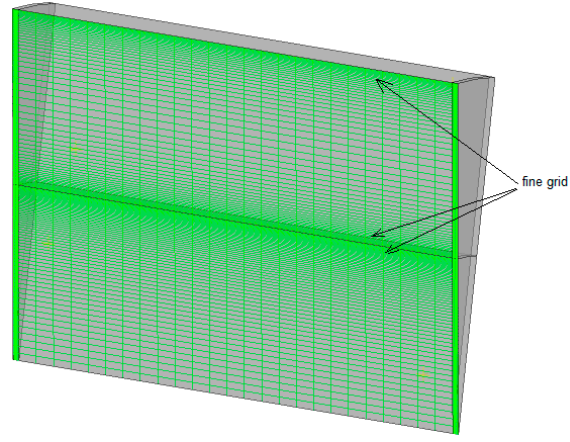
Figure 4. Computational mesh with densification areas at the